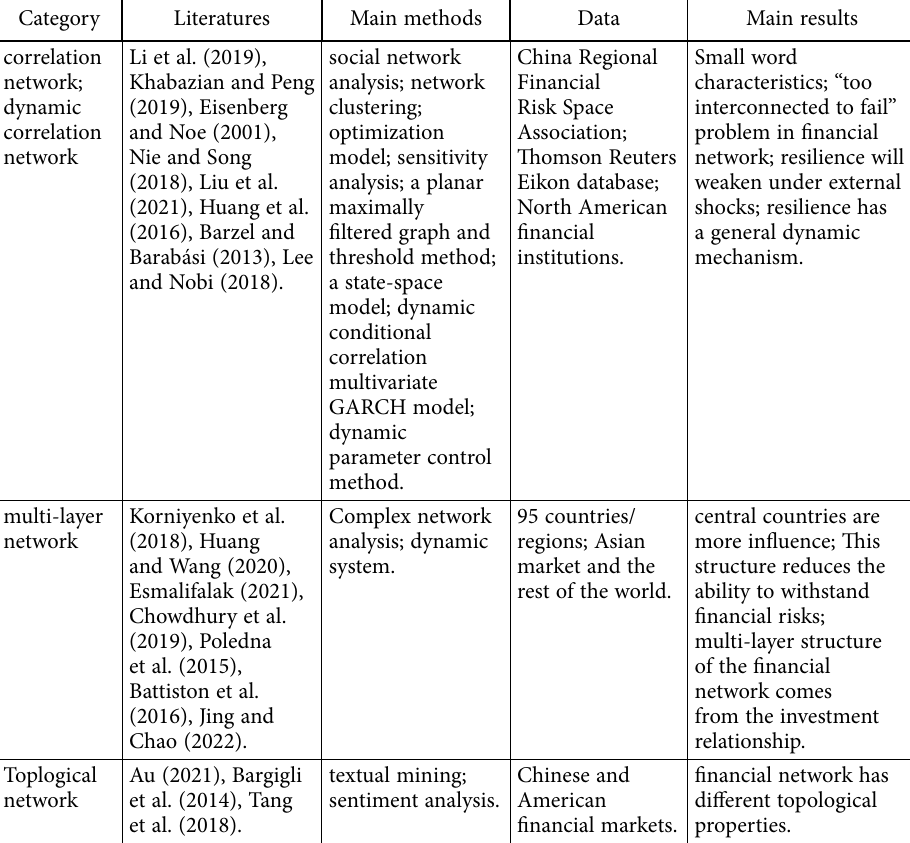
Table 2. Representative research methods for network resilience Category Literatures Main methods